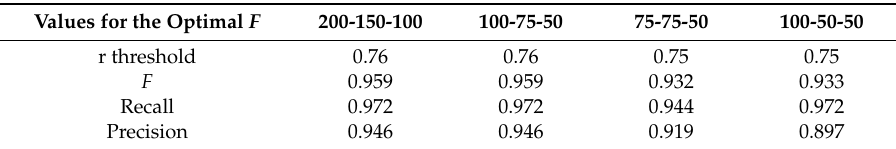
Figure 10. F scores for three stacked auto-encoders and 200-150-100, 100-75-50, 75-75-50, 100-50-50, and 100-50-20 hidden units. Table 5. Optimal values for the F score for each configuration.